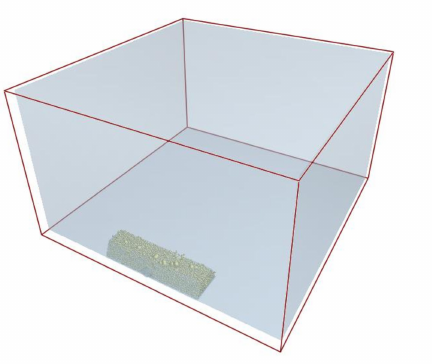
Figure 11. Geometric model of the flow field.